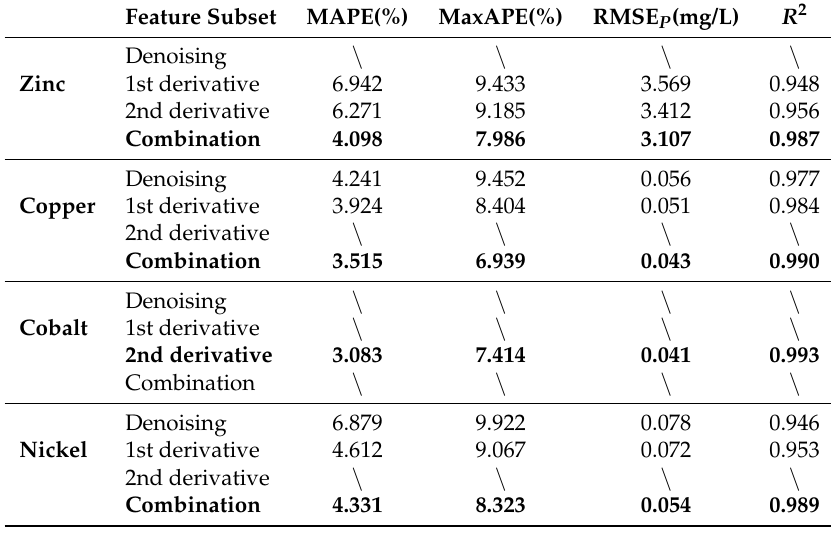
Table 4. Model prediction results of extracted variables subsets and their combinations under different preprocessing methods for metal ion concentration